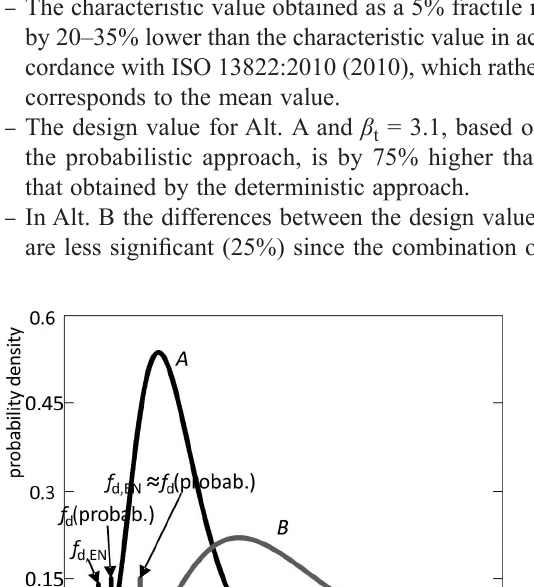
B (bricks + sandstone)